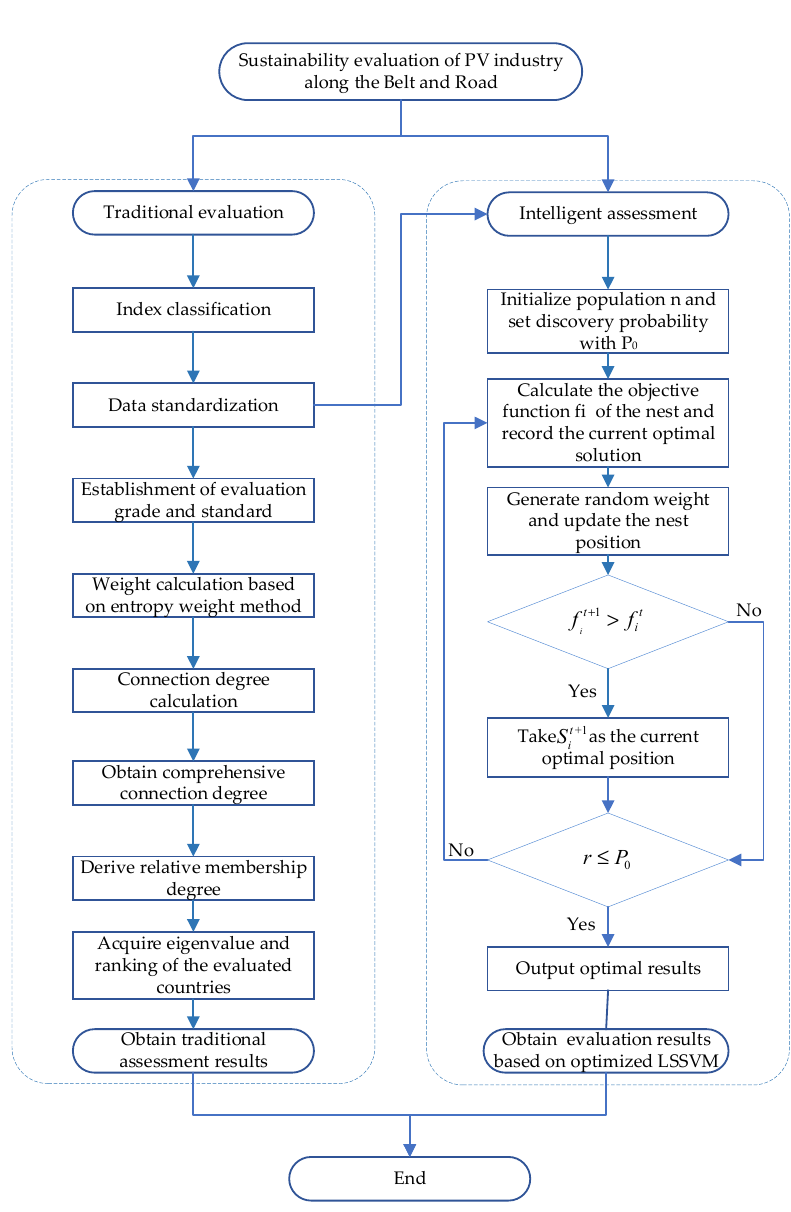
Figure 1. The assessment framework of the proposed model.